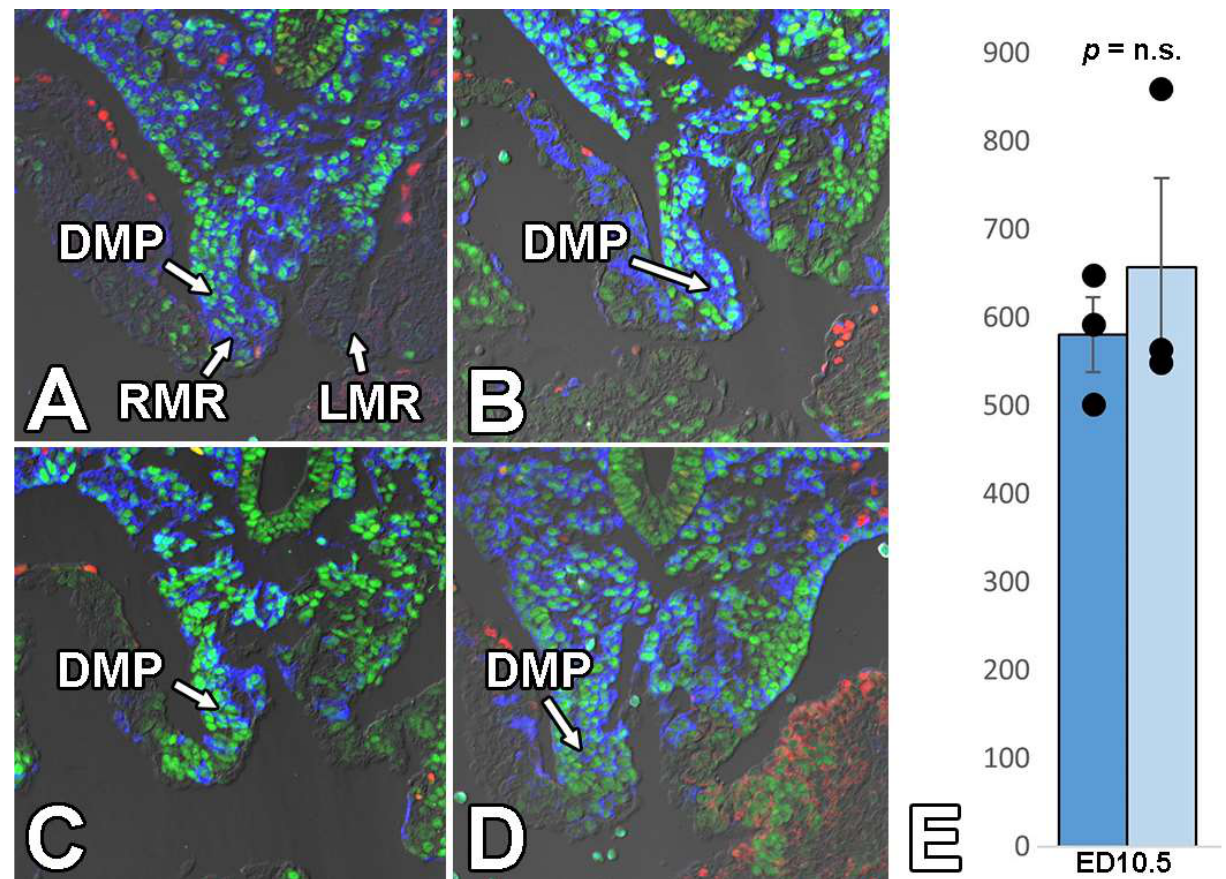
Figure 8. Deletion of Sox9 from the SHF does not affect DMP development. Panels ( A , B ) shows the DMP in ED10.5 SHFcre;Sox9fl/+;R26mG control hearts. The sections are stained for Isl1, a transcrip- tion factor preferentially expressed in the SHF (green), Sox9 (red), and GFP (blue). Panels ( C , D ) show the DMP in SHFcre;Sox9fl/fl;R26mG hearts at ED10.5. The graph in panel ( E ) shows the quantification of the number of cells within the DMP in the controls (dark blue/left) vs. SHFcre;Sox9fl/fl;R26mG hearts (light blue/right). DMP = dorsal mesenchymal protrusion.